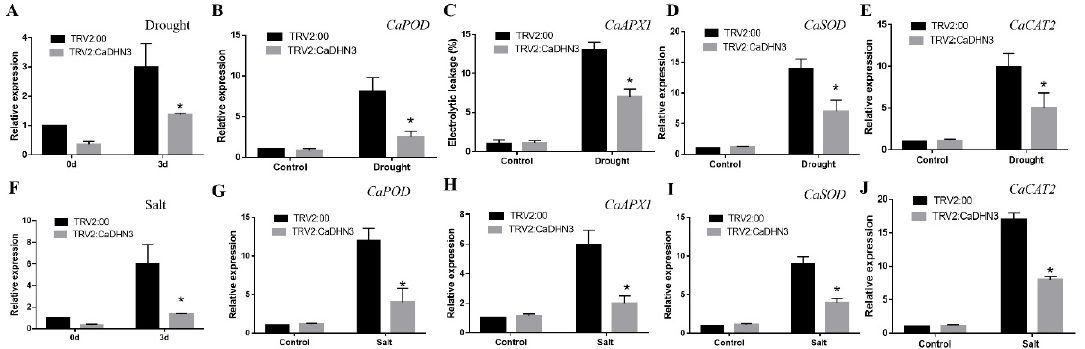
Figure 4. Reactive oxygen species (ROS) scavenging enzymes related gene expression after 3 days of salt stress and 7 days of drought stress. ( A , F ) relative expression of CaDHN3 under drought and salt stress. ( B , G ) relative expression of CaPOD under drought and salt stress. ( C , H ) relative expression of CaAPX1 under drought and salt stress. ( D , I ) relative expression of CaSOD under drought and salt stress. ( E , J ) relative expression of CaCAT2 under drought and salt stress. Mean and S.D. values were obtained from three independent experiments. Asterisks indicate statistical significance (* p < 0.05, Student’s test) compared to